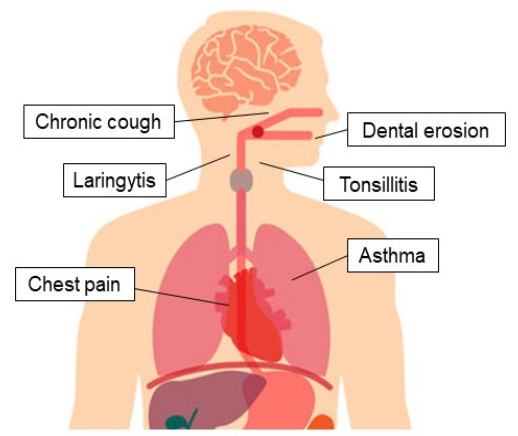
Figure 1. Extra-esophageal presentation of gastroesophageal reflux disease.